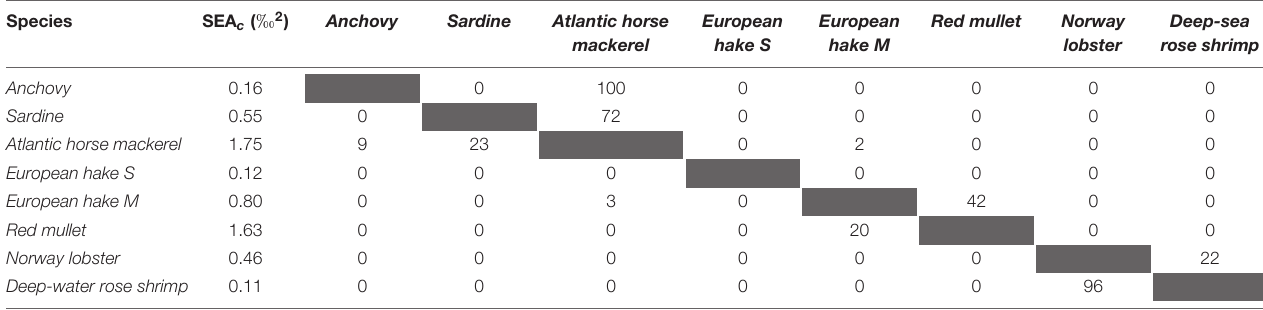
TABLE 5 | Standard Ellipse Area corrected for small sample (SEA c ) and SEA c overlap percentage between sampled species in the Middle area of the Adriatic Sea (values indicate SEA c overlap of the species in the row with the species in the column).